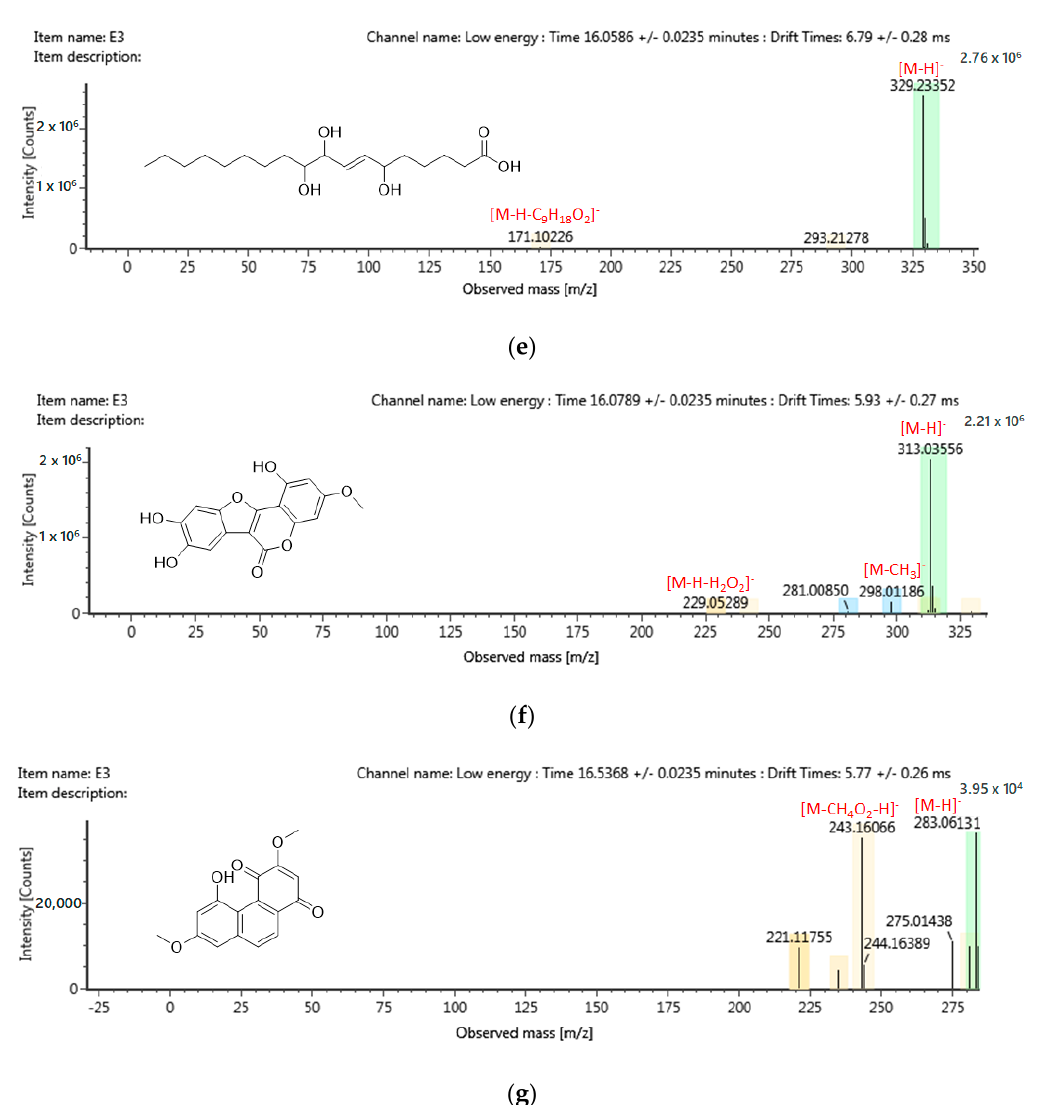
Figure 6. MS/MS spectra fragmentation of tentatively assigned compounds with potential anti-cancer properties from F3 as ( a ) 5,7-Dihydroxy-chromone, ( b ) Kaempferol, ( c ) Quercetin, ( d ) Rhein, ( e ) Sanleng acid, ( f ) Wedelolacetone and ( g ) Denbinobin.